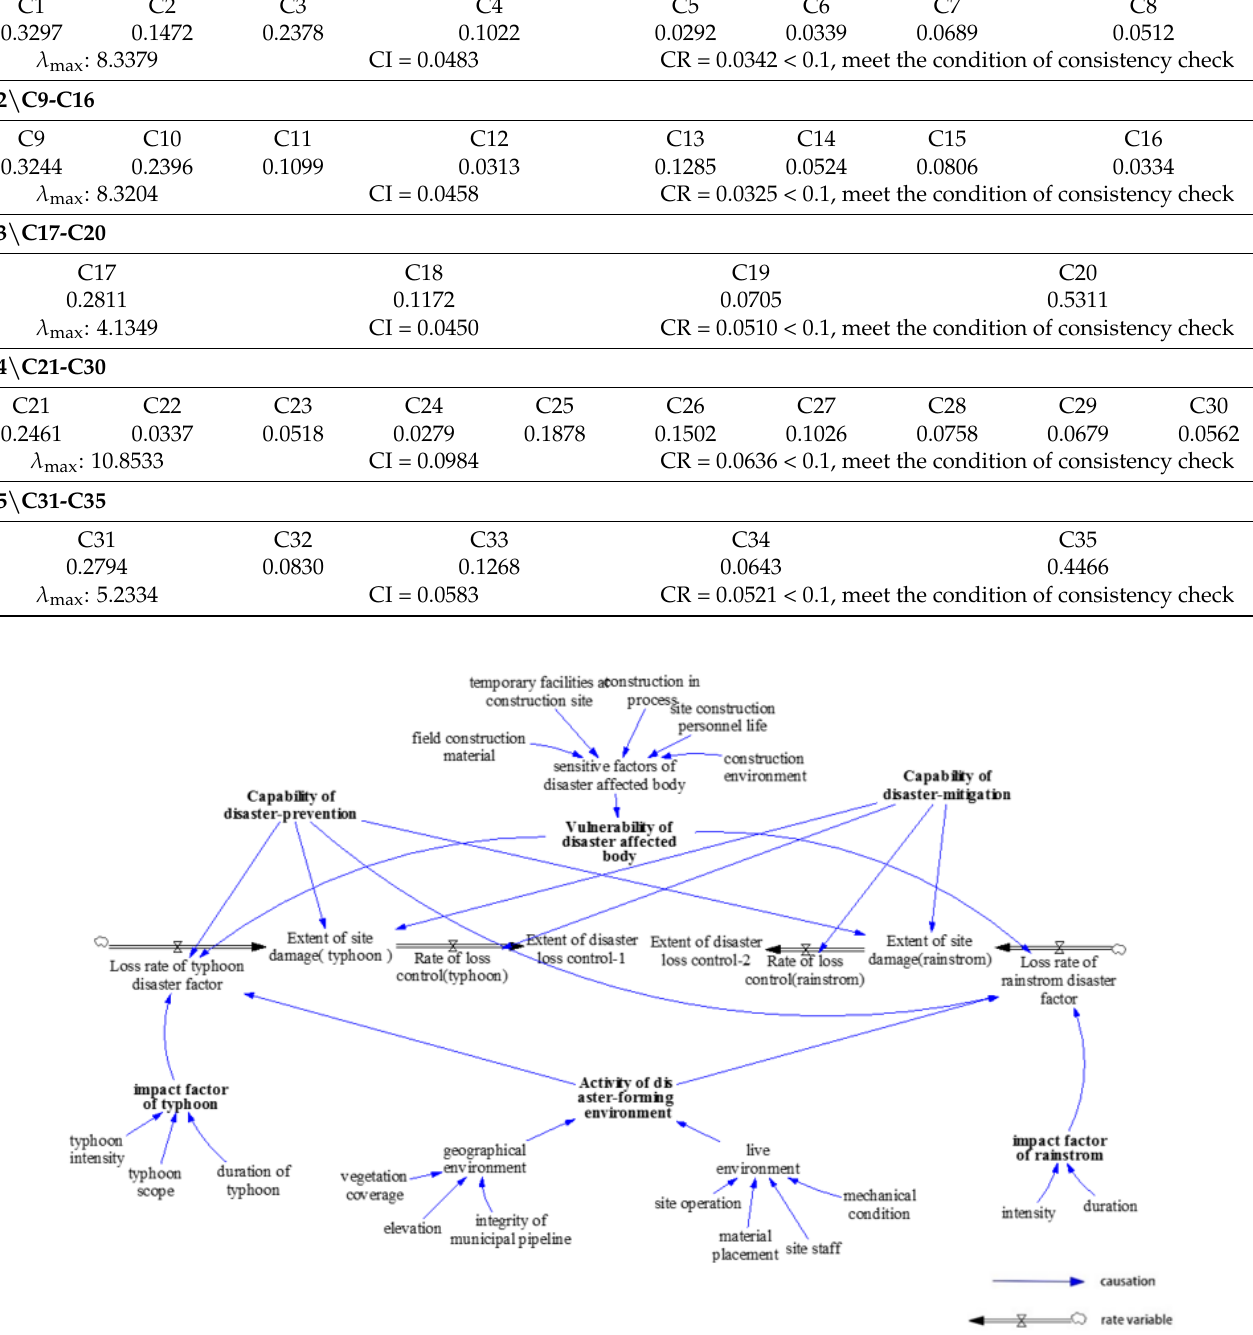
Figure 4. Xiamen Electronic City project under construction. 4. Case Study and Process Design 4.1. Image Collection at the Construction Site In this study, the Xiamen Electronic City project under construction was used as the case to collect images of the construction site. Xiamen Electronic City· International Inno- vation Center project is located in Jimei District, Xiamen City, Fujian, China, with a total area of 103,200 m 2 and a total construction area of about 570,000 m 2 (as shown in Figure 4). In this study, the construction risk analysis was carried out by building 3D and 2D models of the construction site, and the real-time image data acquisition of the construc- tion site was carried out by UAV to verify the feasibility of the plan. The experiment used the DJI PHANTOM4 PRO V2.0. The specific parameters of the UAV and its load sensor are shown in Table 9. The point cloud model of the construction site was established based on the site image captured by the UAV. The pixel position information on the image of